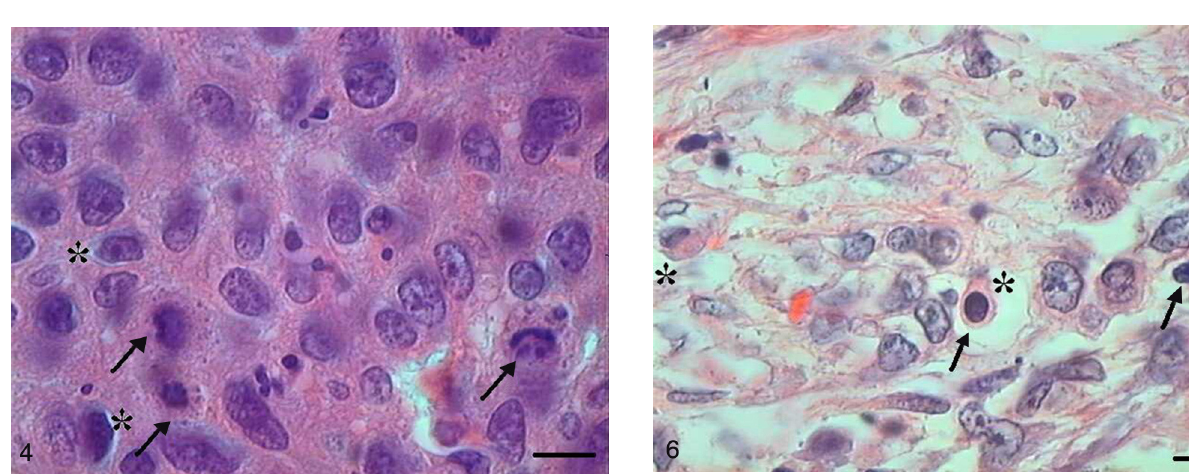
Figure 3 Grade II squamous carcinoma cells. Micrograph of grade II squamous carcinoma cells with connective tissue infil- tration by tumor cells (HE, bar = 100 (cid:2) m).